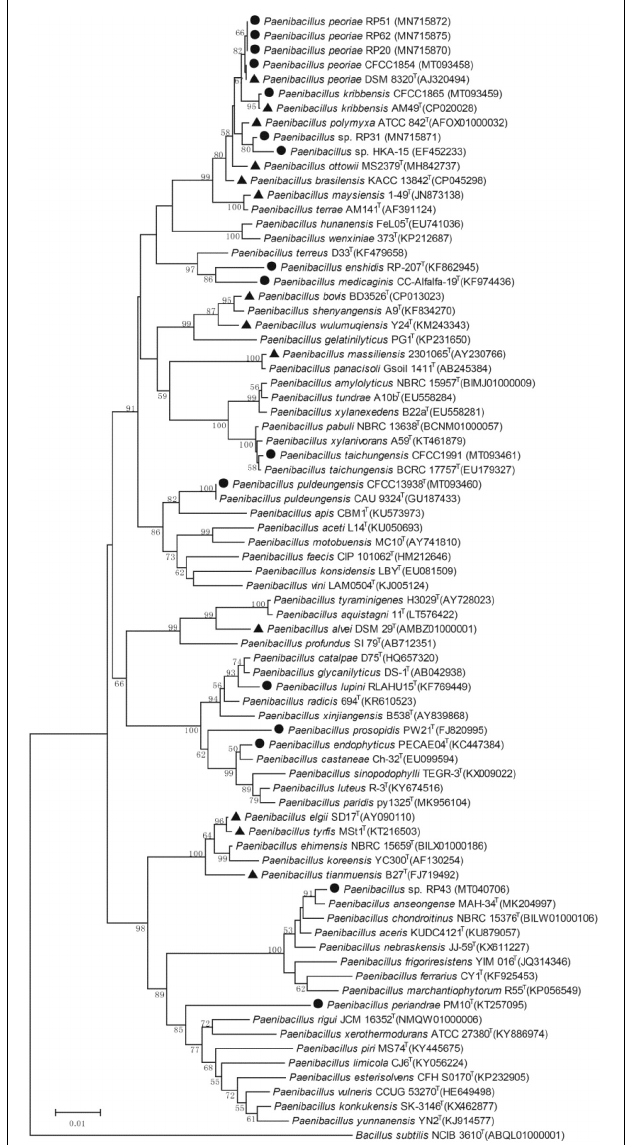
FIGURE 1 | Neighbor-joining phylogenetic tree based on 16S rRNA gene sequences (1319 positions) of nodule-inhabiting Paenibacillus strains ( • ), Paenibacillus strains containing fus gene cluster ( (cid:78) ), and their relatives. Bacillus subtilis NCIB 3610 T was used as outgroup. The percentages of replicate trees ( > 50%) in which the associated taxa clustered together in the bootstrap test (1000 replicates) are shown at the nodes. The GenBank accession numbers of the 16S rRNA gene sequences are indicated in brackets. The scale bar indicates 0.01 substitutions per